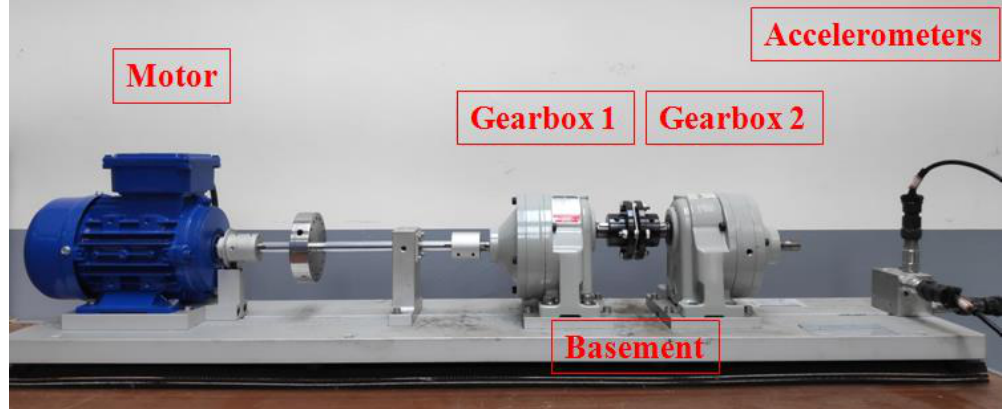
Figure 4. Experimental platform of helical gearbox driven by motor.